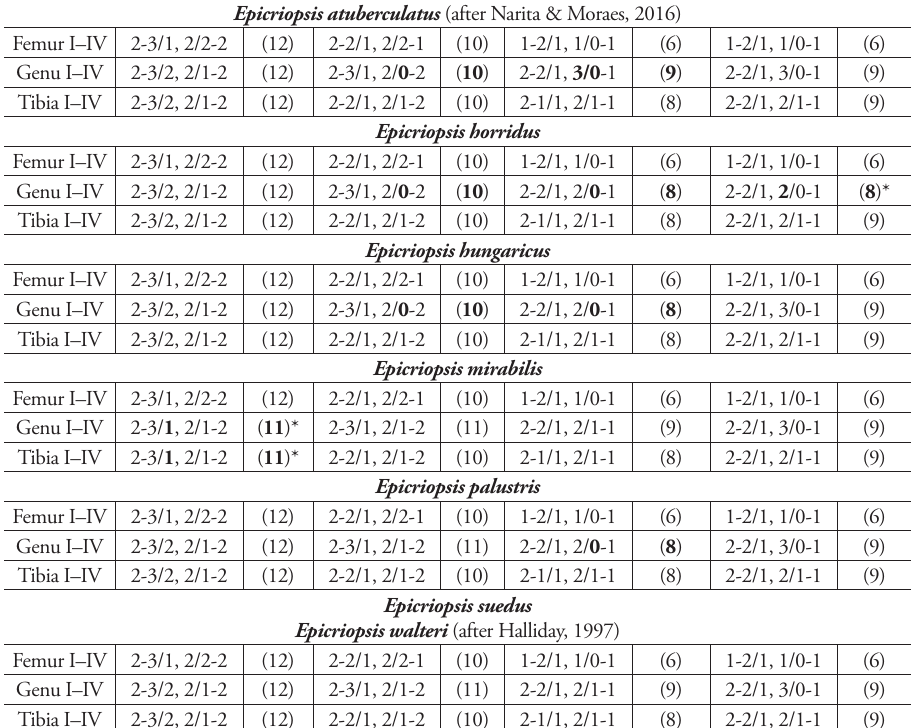
Table 2. Leg chaetotaxy in adults of Epicriopsis with known leg chaetotaxy. Figures in bold face represent infrequent numbers of setae (* – autapomorphic expression of leg setation). Epicriopsis atuberculatus (after Narita & Moraes,